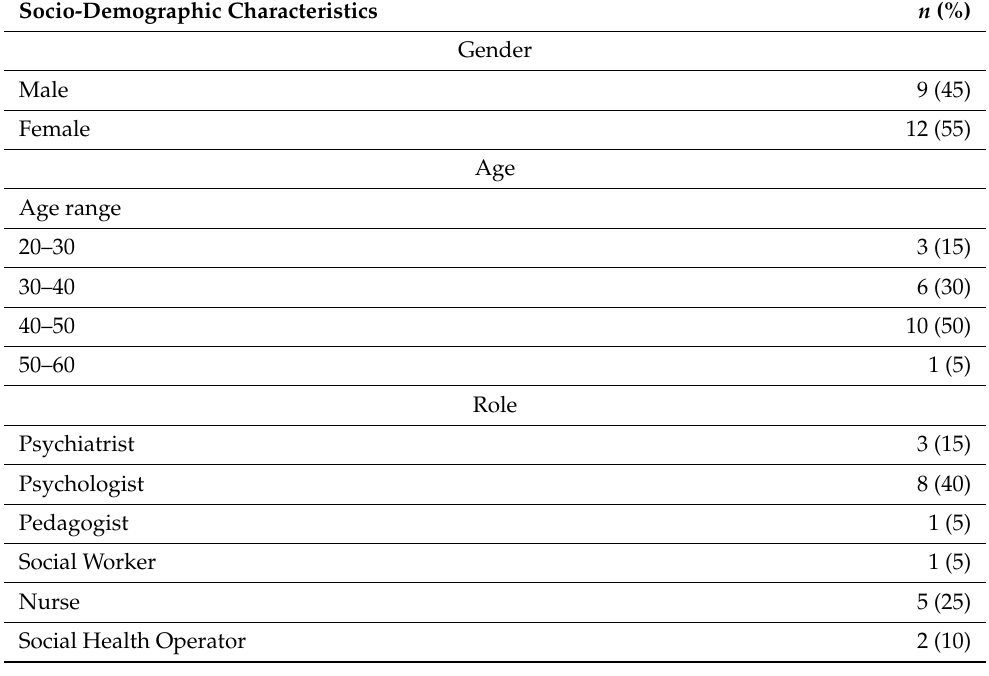
Table 1. Participants’ characteristics.